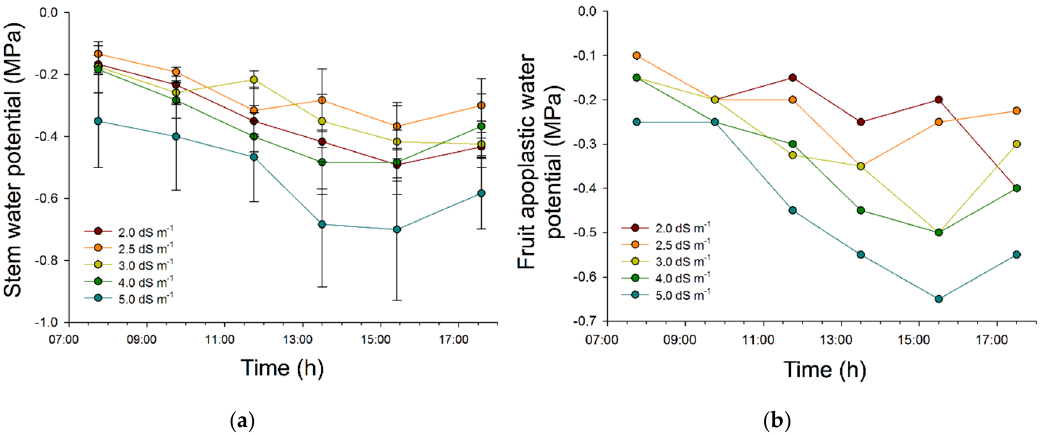
Figure 1. ( a ) Xylem water potential measured for stem ( n = 3); and ( b ) apoplastic water potential measured for fruit, and this for the various salinity treatments.